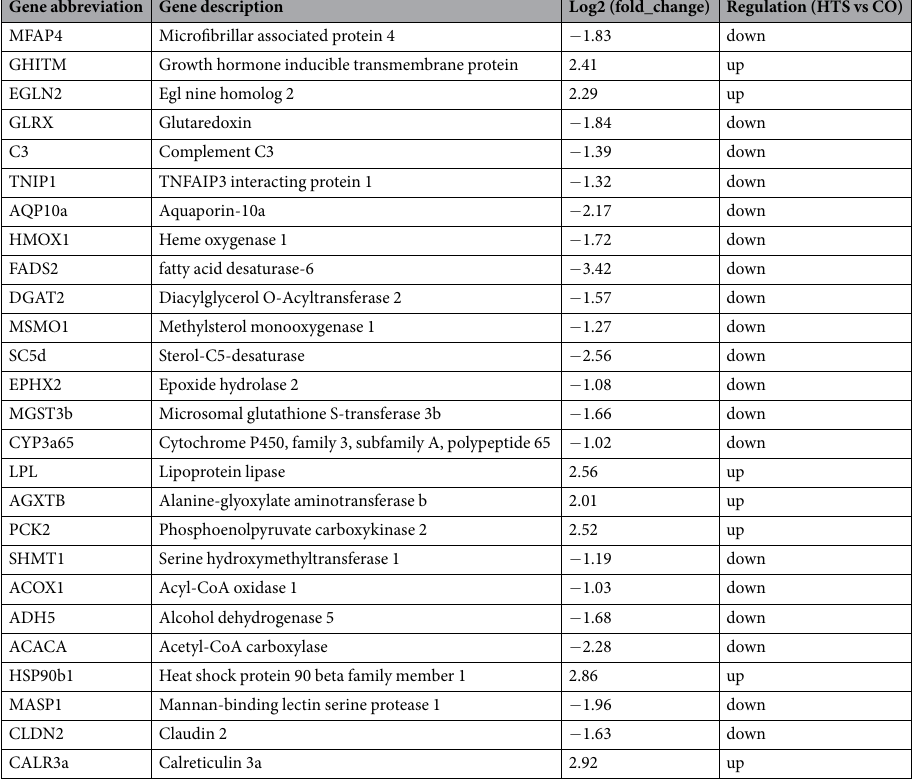
Table 4. The 26 differentially expressed mRNAs in heat-stressed GIFT liver verified by mRNA-Seq. Fold change = HTS group (mean)/CO group (mean), where “mean” is the mean of three biological